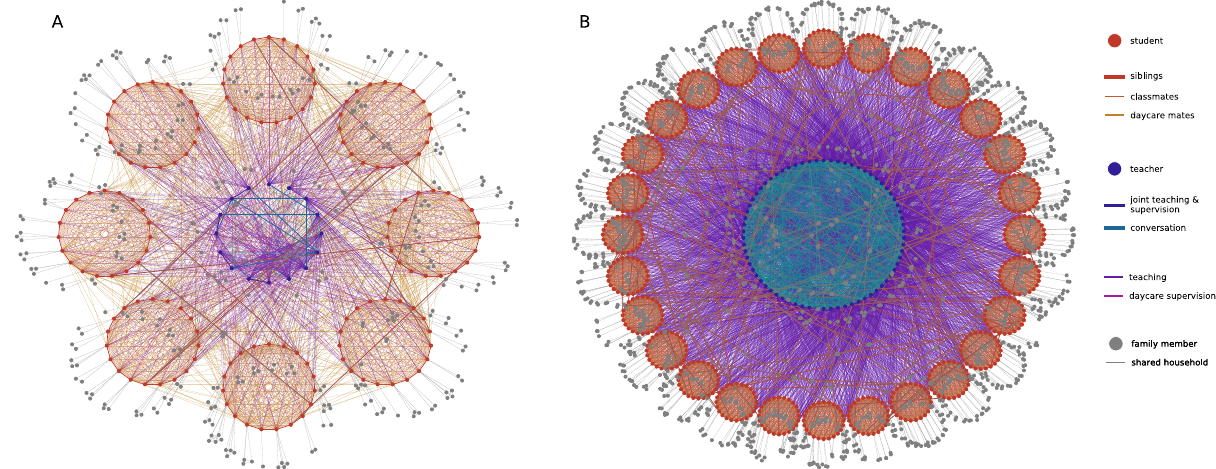
Fig. 2 Contact networks of agents in schools. A Representative Austrian primary school with afternoon daycare, including 8 classes with 19 students each, 16 teachers, and their respective family members. B Typical Austrian secondary school, including 28 classes with 24 students each, 70 teachers, and their respective family members. Contacts between students (red circles) are depicted in shades of red and include contacts between class mates, students in the same daycare supervision group and siblings. Contacts between teachers (blue circles) are depicted in shades of blue and include contacts between teachers that teach or supervise together or have meetings. Contacts between household members (grey circles) are depicted as grey lines. Contacts between teachers and students that arise during teaching or daycare supervision are depicted as purple and pink